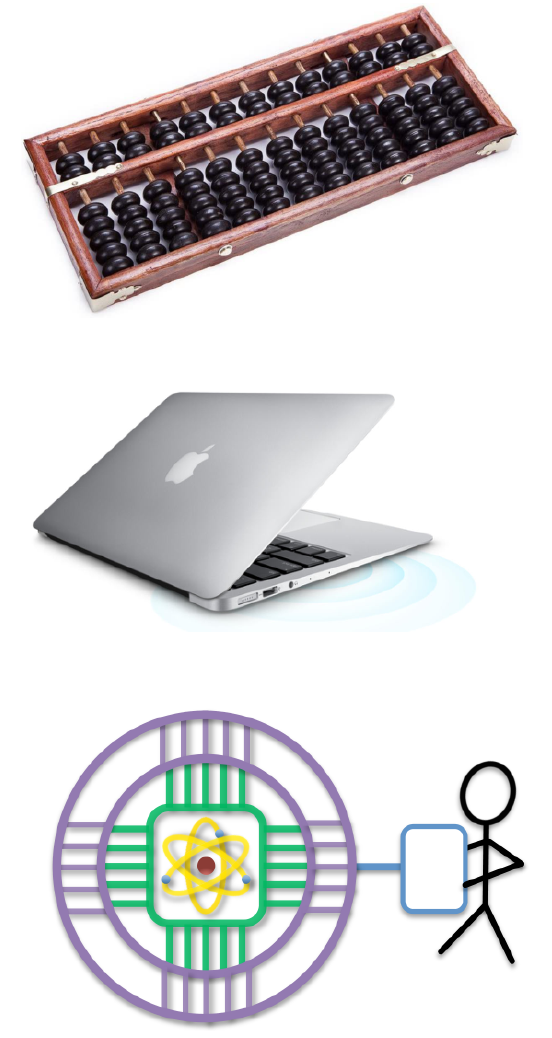
Figure 1 . An illustration of a Chinese abacus (top), a Mac laptop computer (middle), and a quantum computer cartoon (bottom). The Chinese abacus generally has two decks divided by a beam, with five beads on each rod in the bottom deck and two beads each in the top deck. The beads are counted by moving them toward the beam, with each top bead for 5 and each bottom bead for 1